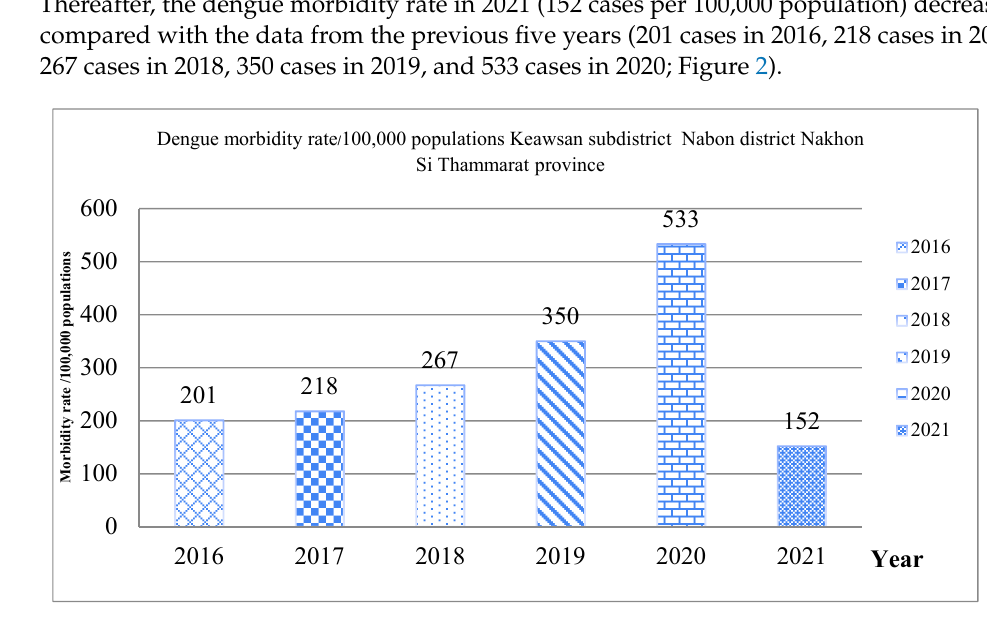
Figure 2. Compare dengue morbidity rate of Keawsan subdistrict.